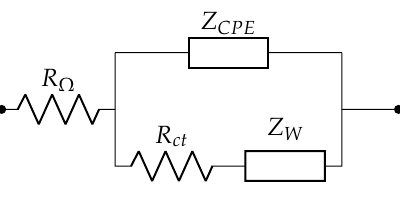
Figure 2. The Fouquet model ( N p = 6).